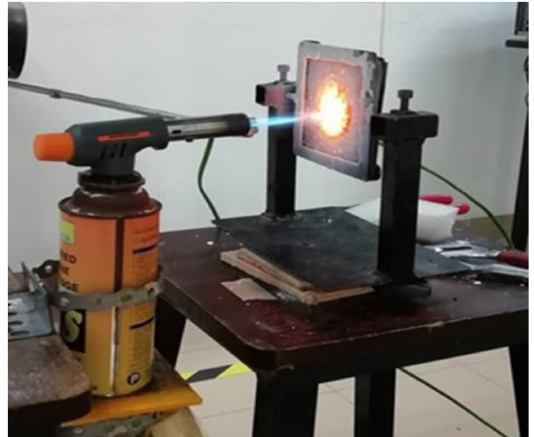
Figure 6. Setup for the fire retardant